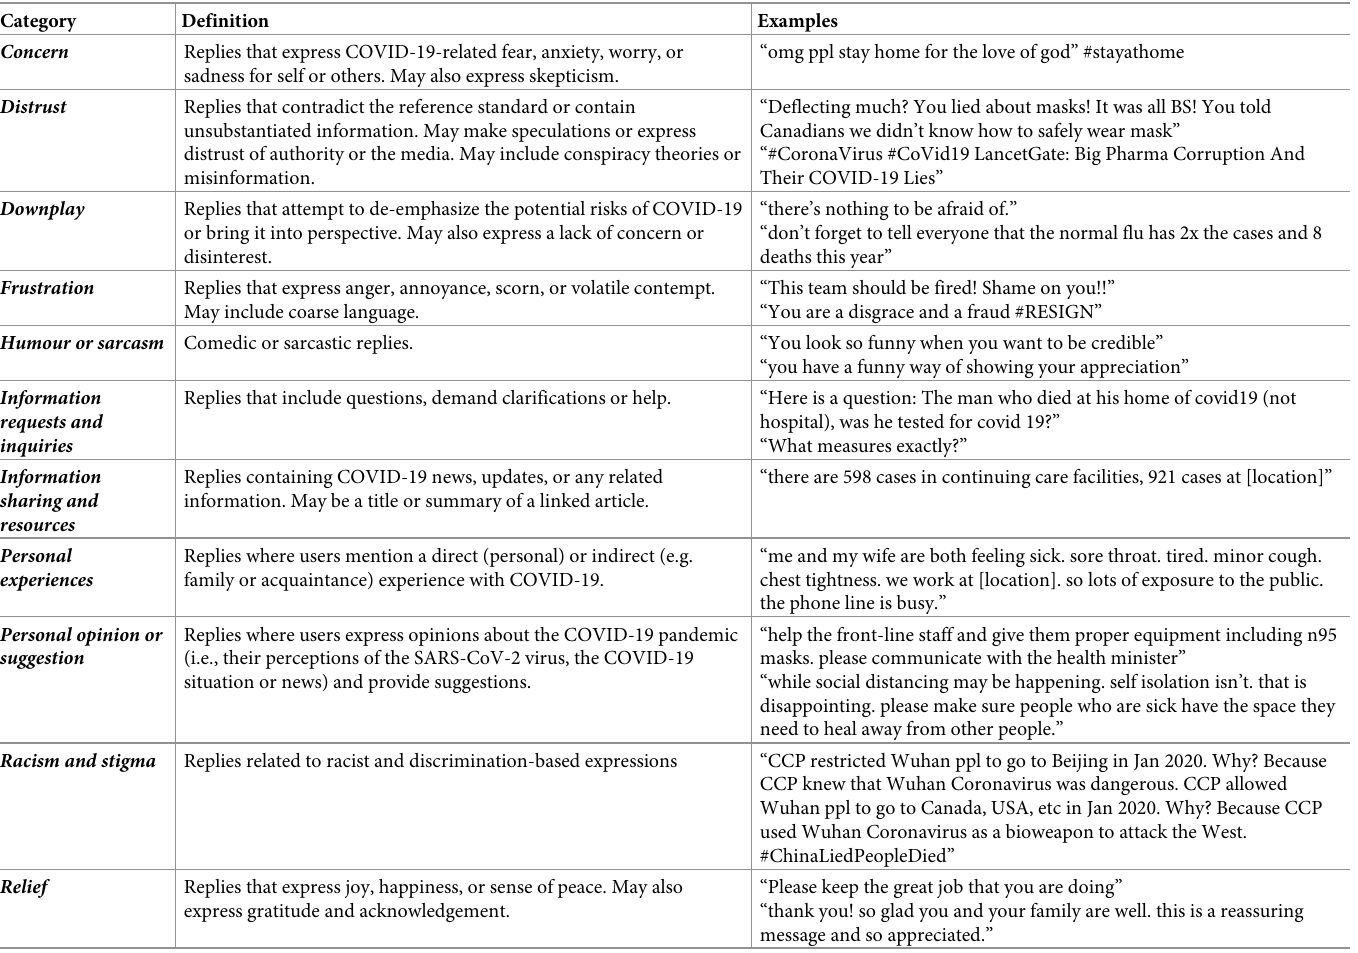
Table 1. The final categories of sentiments, their definition, and examples of tweets for each category. Category